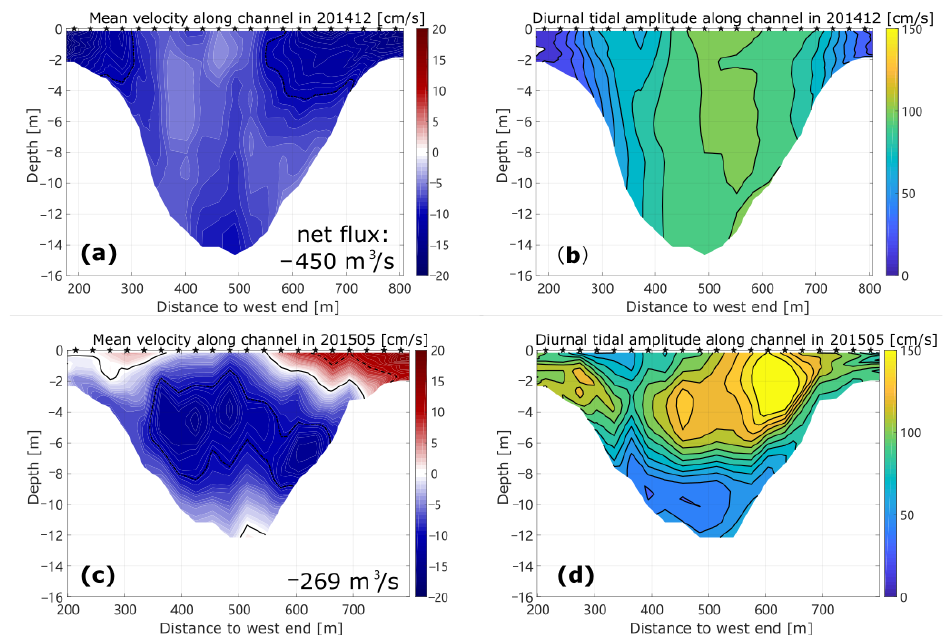
Figure 2. Subtidal and tidal current velocities in the along-channel direction during investigations in December 2014 ( a , b ) and May 2015 ( c , d ). The dotted, solid, and dashed lines ( a , c ) represent − 10, 0, and 10 cm/s, respectively, while the sketched intervals ( b , d ) both represent 10 cm/s. The net transport estimated from the mean velocity along the channel are labeled ( a , c ), with negative signs indicating outward flow from the bay.